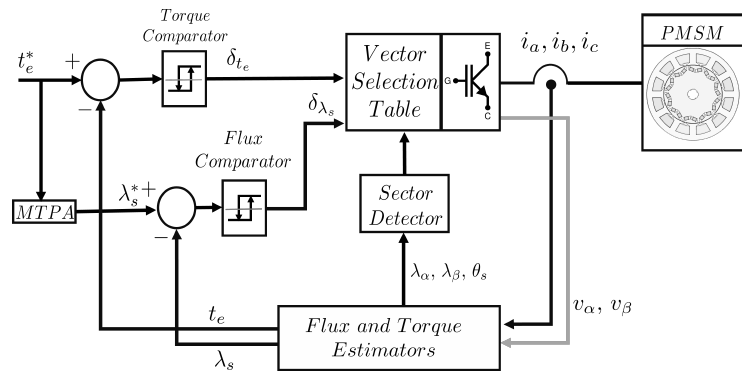
Figure 2. Torque and flux regulation loop in DTC